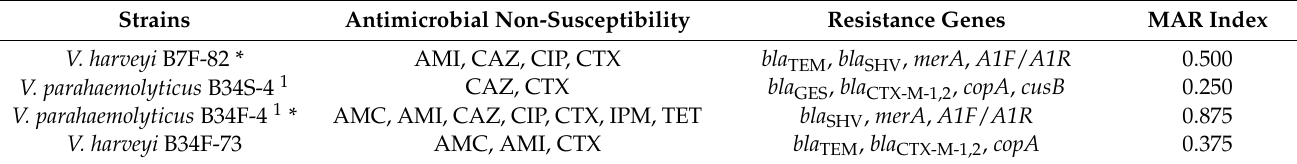
Table 2. ESBL-positive Vibrio spp., their respective antimicrobial non-susceptibility, resistance genes detected, and MAR